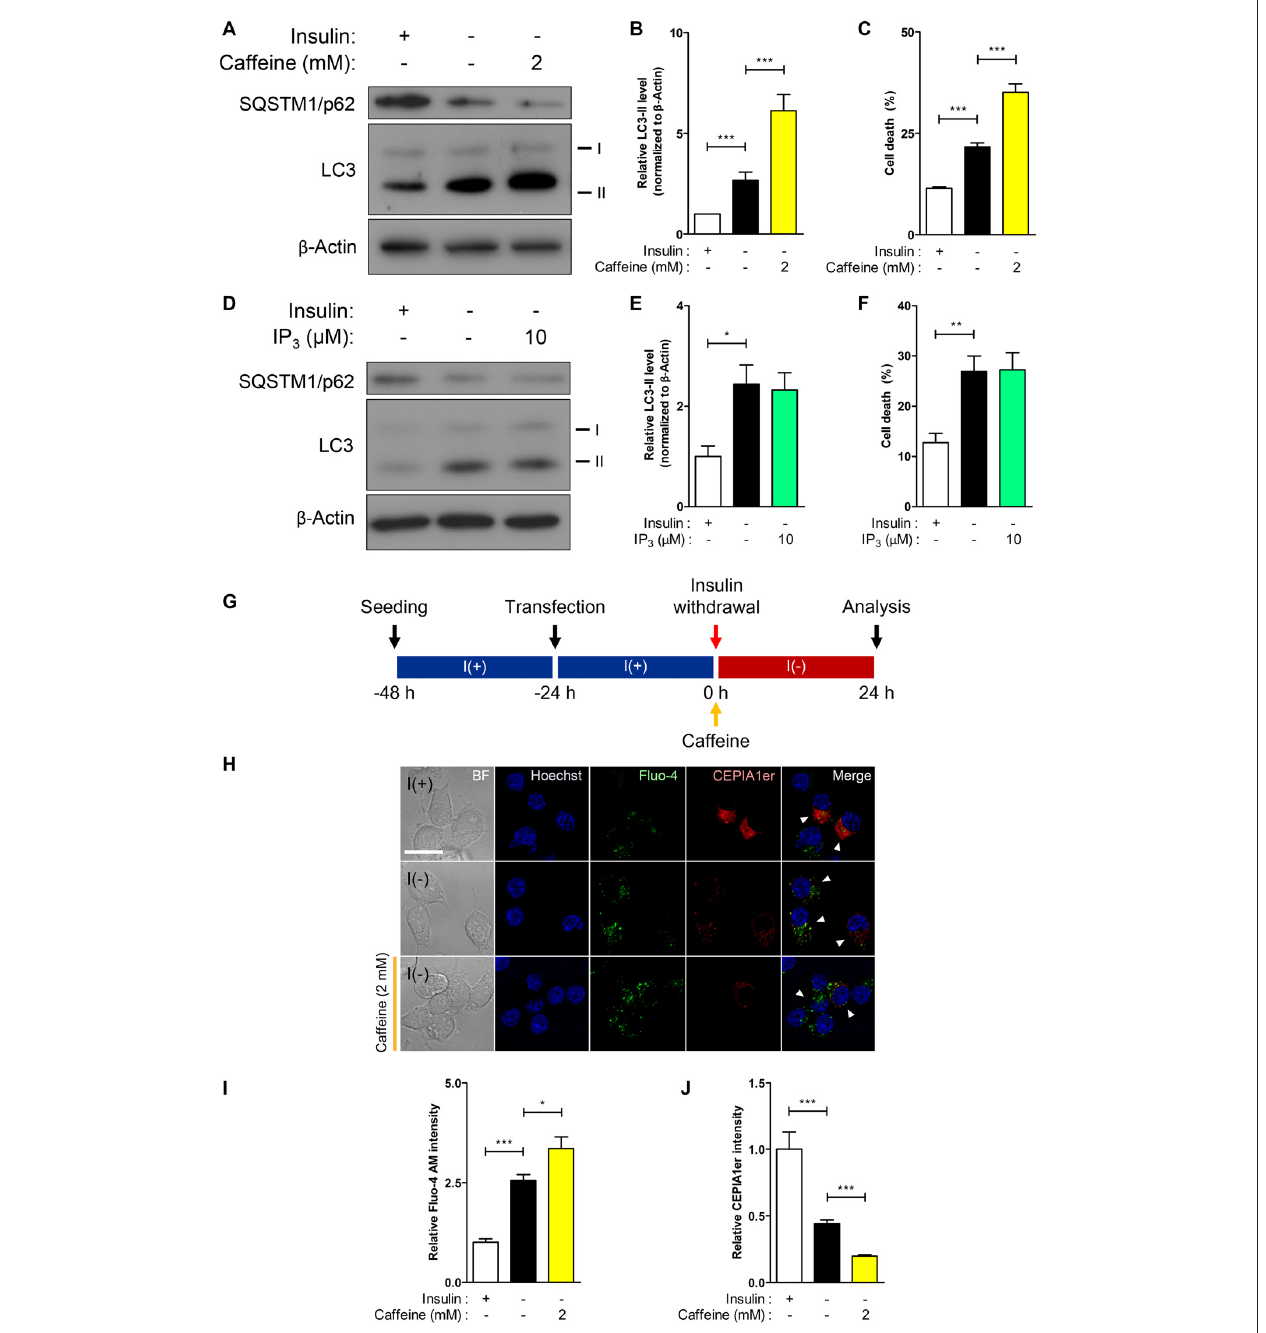
FIGURE 3 | RyR agonist caffeine potentiates autophagic cell death (ACD) in I( − ) HCN cells. (A–C) Effect of caffeine on autophagy and cell death was analyzed in HCN cells. (A) Western blot analysis of the autophagy marker proteins LC3 and SQSTM1/p62 in I( − ) HCN cells treated with caffeine for 24 h. The signal intensity of LC3-II was quantified in (B) using the ImageJ software and normalized to β -actin ( n = 7). (C) Rate of cell death measured in parallel sets of experiments as conducted in (B) . (D–F) Analysis of inositol 1,4,5 triphosphate (IP 3 ) effect on autophagy and cell death in I( − ) HCN cells treated with IP 3 for 24 h. (D) Western blot analysis of LC3 and SQSTM1/p62 in I( − ) HCN cells treated with IP 3 . The signal intensity of LC3-II was quantified in (E) using the ImageJ software and normalized to β -actin ( n = 7). (F) Rate of cell death measured in parallel sets of experiments conducted in (E) . (G–J) Levels of intracellular and ER Ca 2 + in I( − ) HCN cells treated with caffeine for 24 h were measured by Fluo-4 AM and pCMV R-CEPIA1er, respectively. (G) An experimental scheme for immunofluorescence-based analysis of Ca 2 + in HCN cells. (H) Immunofluorescence images of Fluo-4 AM and pCMV R-CEPIA1er in caffeine-treated I( − ) HCN cells compared to I( − ) alone or I(+) cells. Cells subjected to analysis are indicated by arrowheads. Scale bar, 10 µ m. (I,J) Fluorescence intensities of Fluo-4 AM (I) and CEPIA1er (J) were quantified ( n = 40 for I(+), 36 for I( − ), 47 for I( − )/Caffeine). The bars represent the mean ± SEM; ∗ p < 0.05, ∗∗ p < 0.01, ∗∗∗ p < 0.001.